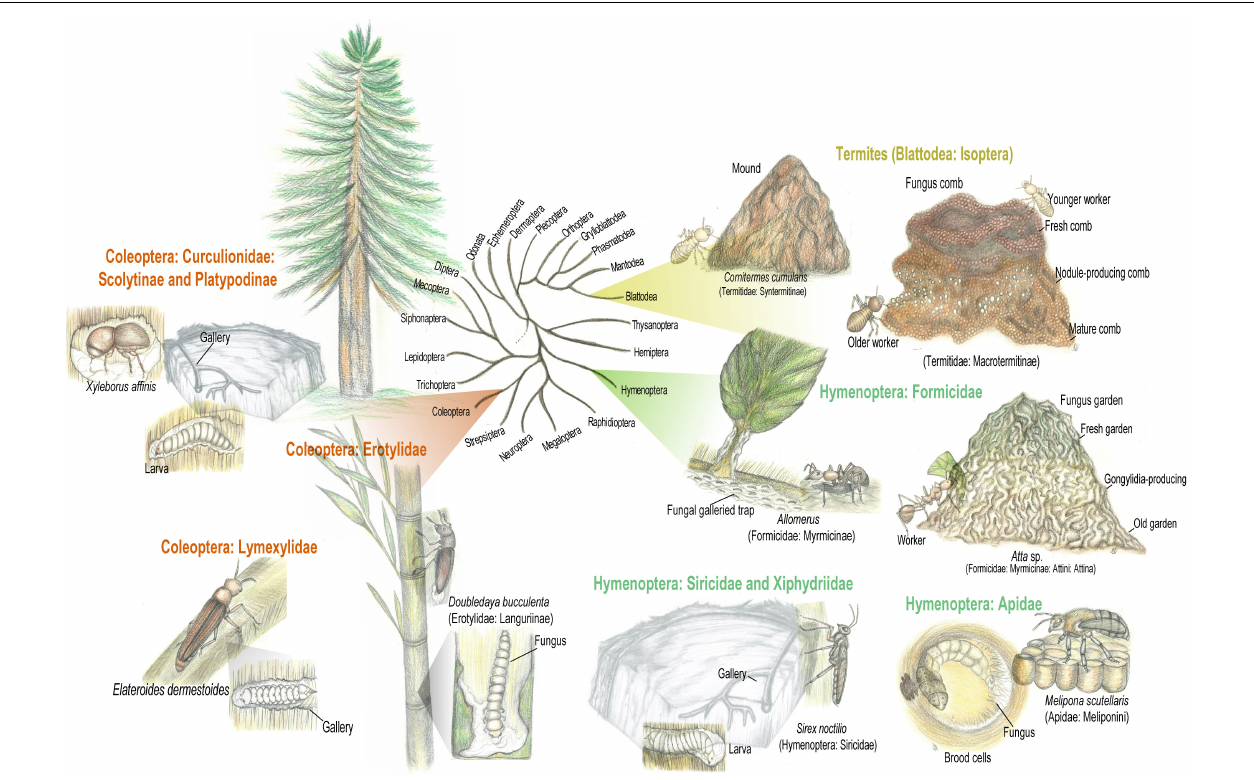
FIGURE 2 | Insect-fungus mutualism evolved in diverse insect orders. Fungal cultivation by insects may occur in two main configurations: (i) Proto-fungiculture, where insects passively propagate fungi that provide either dietary enrichment, protection against pathogens, or structural reinforcement to the